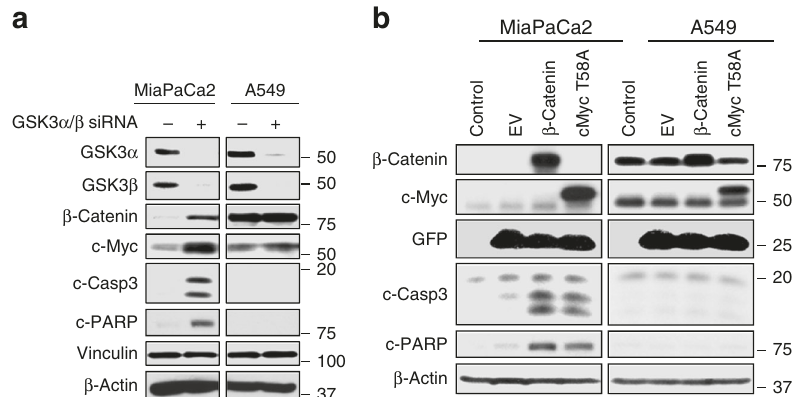
Fig. 5 a GSK3 α / β depletion induces β -catenin and c-Myc in MiaPaCa2 but not in A549 cells. The cells were transfected with GSK3- α / β siRNA or NT siRNA for 72 h and processed for western blotting with the indicated antibodies. Experiment was done three times. b Ectopic expression of CA β -catenin or T58A c-Myc induces apoptosis in MiaPaCa2 but not in A549 cells. Cells were infected with lentiviruses that contain mutant β -catenin that lacks the GSK3 phosphorylation sites, S33/S37/T41, and is therefore constitutively active, or mutant T58A c-Myc that cannot be phosphorylated by GSK3; cells were processed for western blotting after 96 h. Experiment was done three times